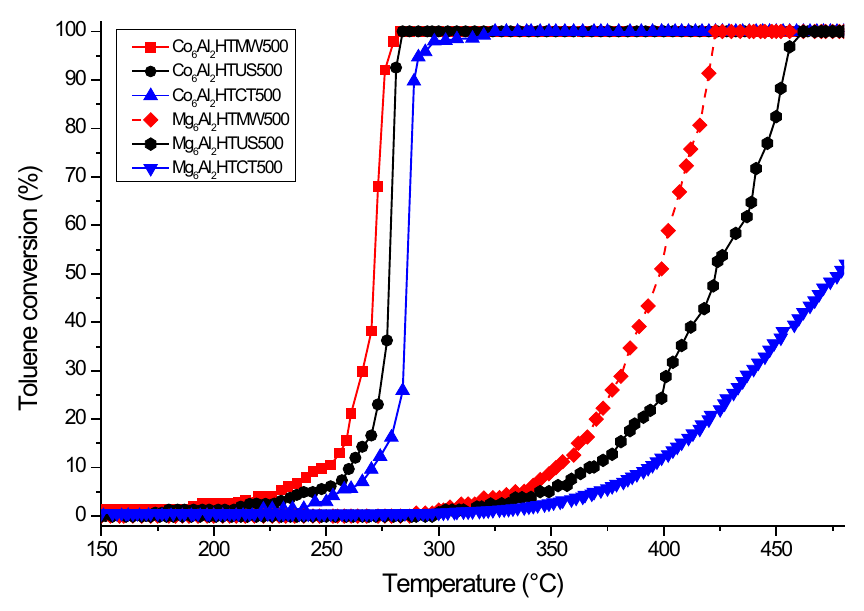
Figure 1. Conversion of toluene (%) on mixed oxide vs. reaction temperature